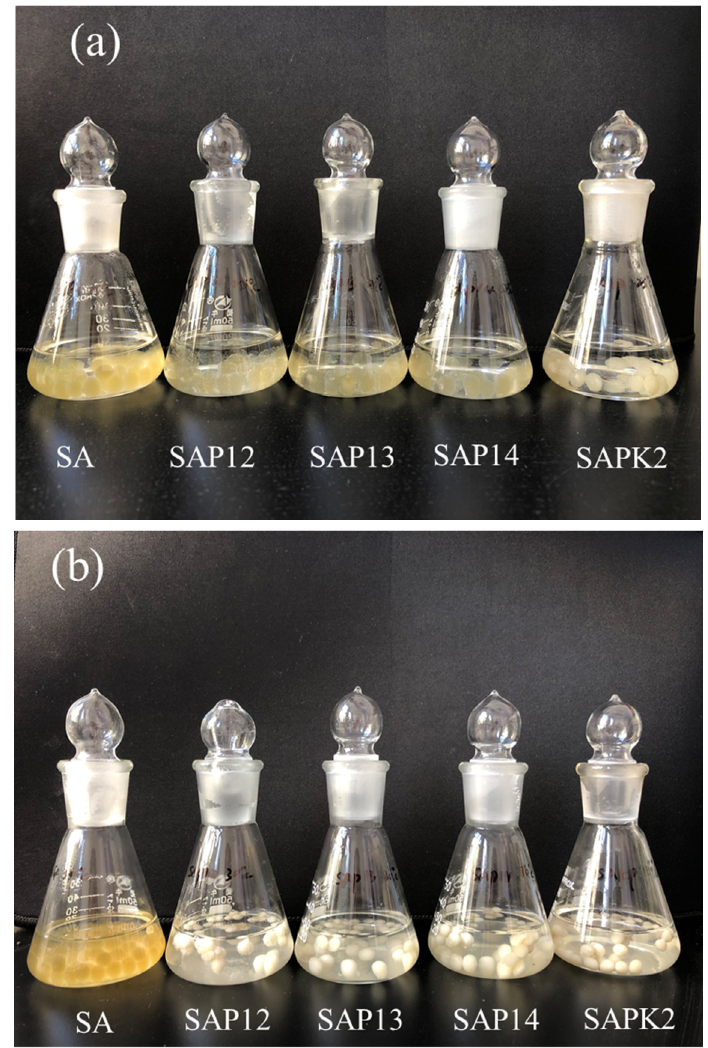
Figure 10. Photograph of hydrogel beads with different compositions ( a ) at 25 °C and ( b ) at 30 °C. The state of beads at 35 °C was close to that at 30 °C. Table 4. Diffusion exponent, kinetic constant, and mechanism for the release of spores.